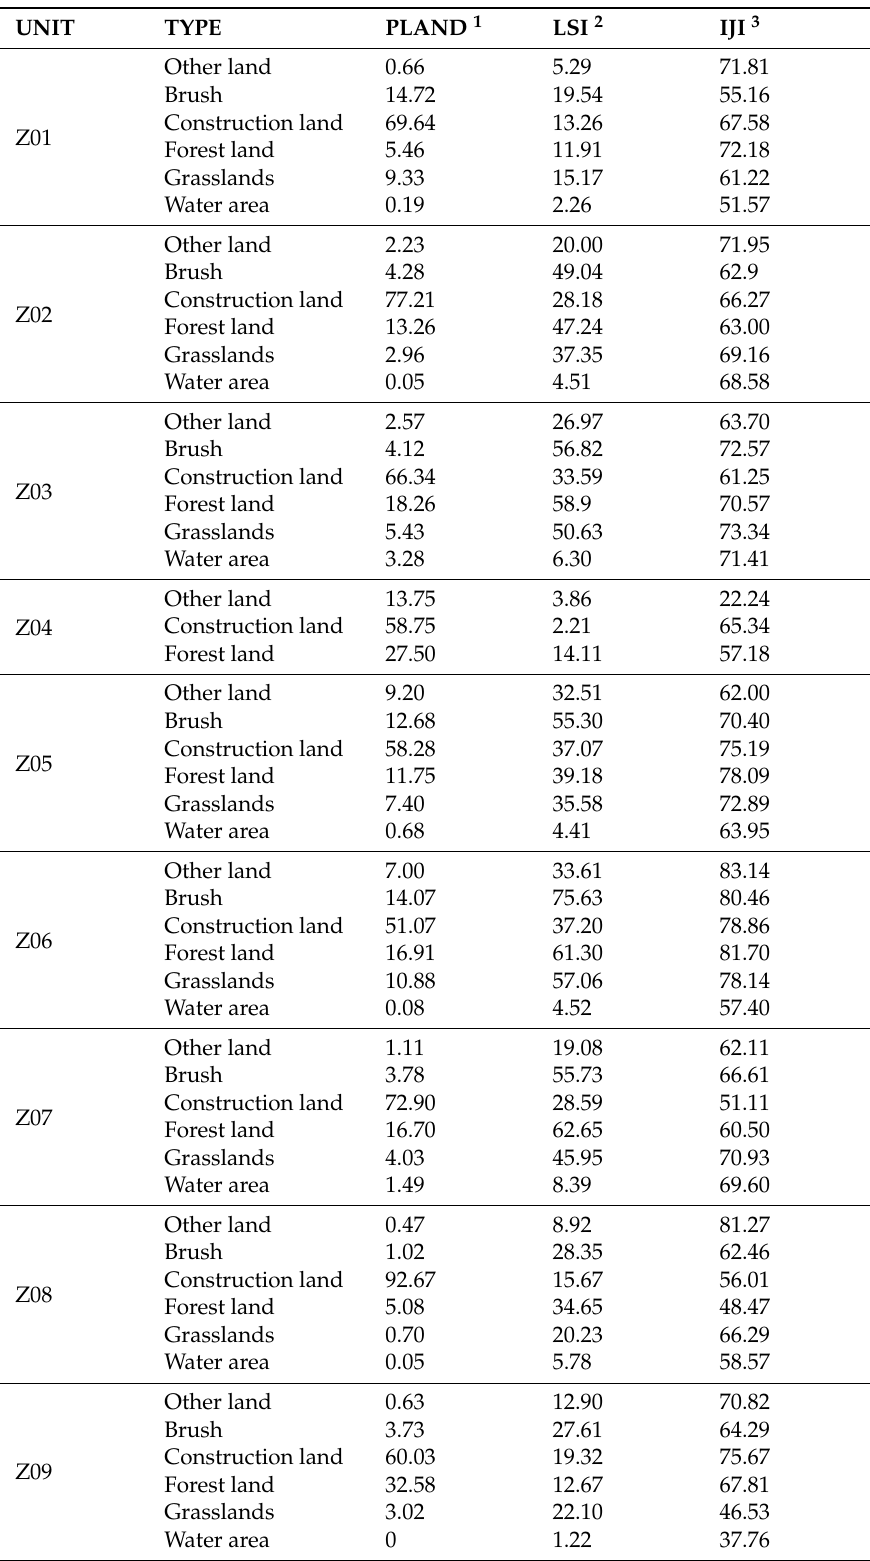
Table 4. Landscape pattern indices of research